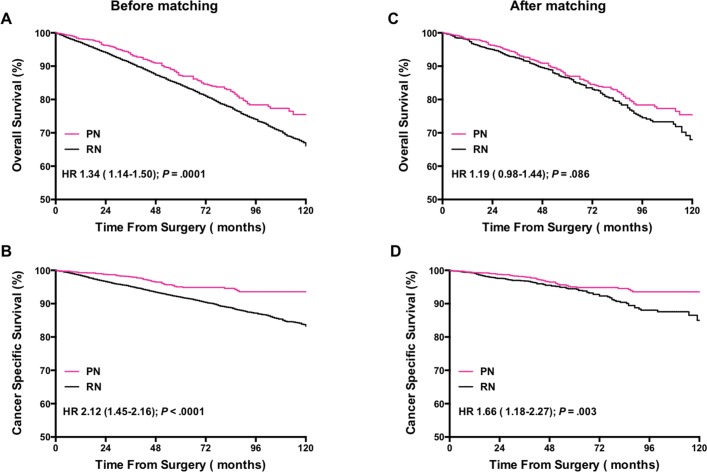
Kaplan-Meier survival curves demonstrating patients’ overall survivals(OS), and cancer-specific survivals (CSS) according to patients’ nephrectomy modalities (partial versus radical) before and after propensity matching.